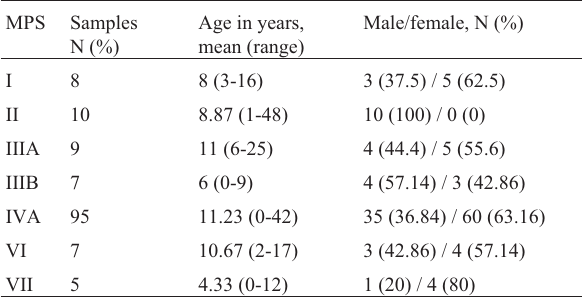
Table 3 - Demographic data for the analyzed patients.